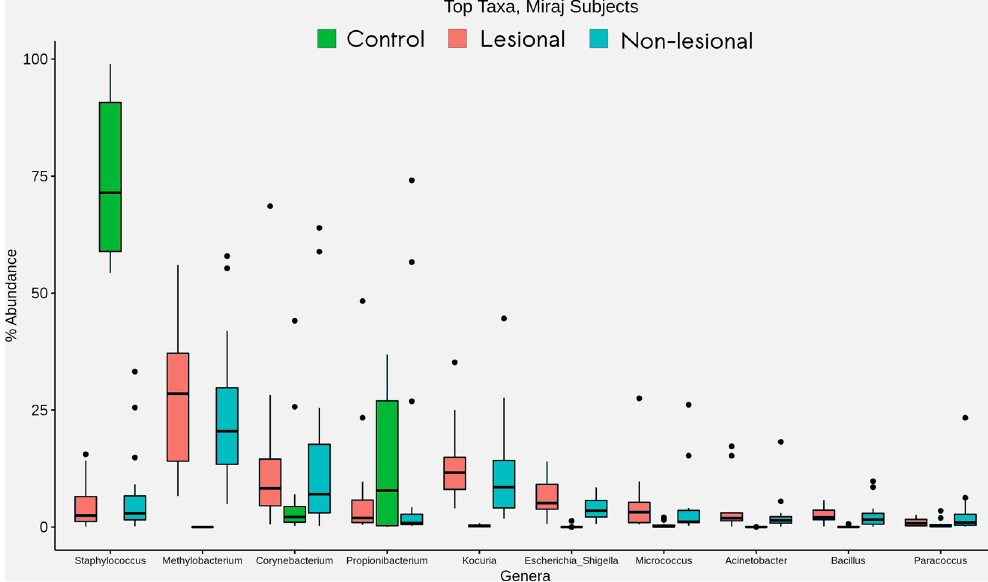
Figure 6. Taxonomic composition of cutaneous microbiome in study participants from Miraj. Box plots representing relative abundance analysis of most abundant bacterial taxa identified in samples obtained from HC, LS and NLS sites of LP in